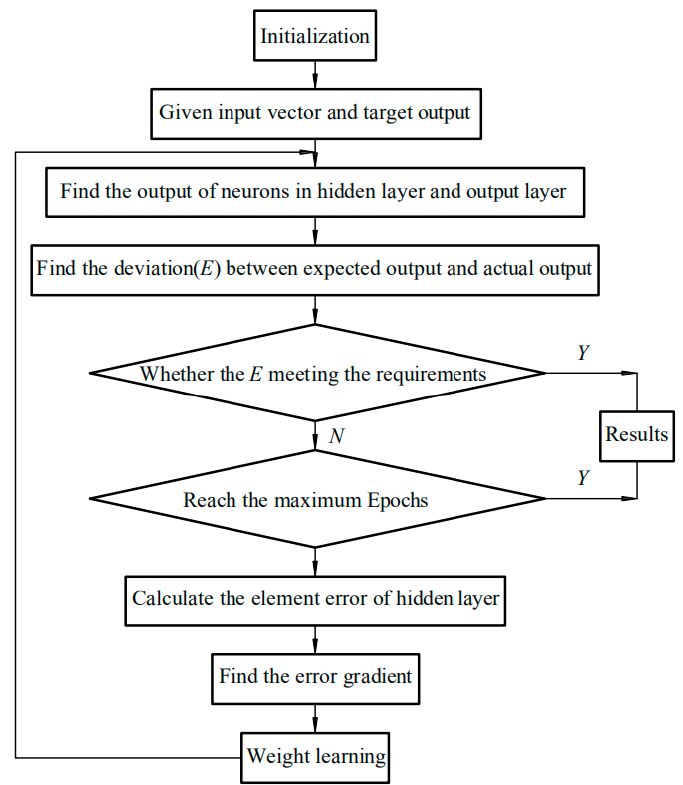
Figure 3. The established IANN model ( a ) and OANN model ( b ).